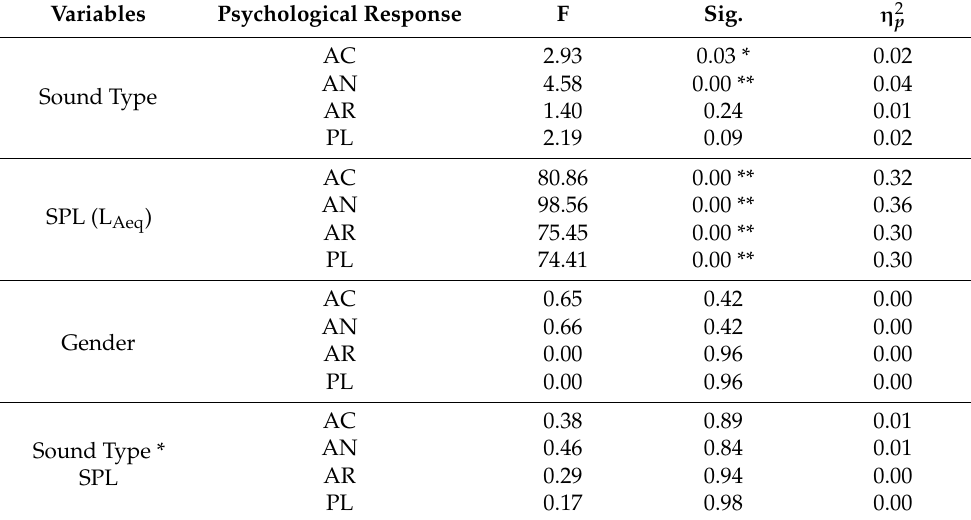
Table 1. Results of multivariate tests of psychological evaluations to traffic sounds. AC, AN, AR, and PL represent the evaluation of acoustic comfort, annoyance, arousal, and pleasantness, respectively. * and ** represent significant difference at 0.05 and 0.01 level,